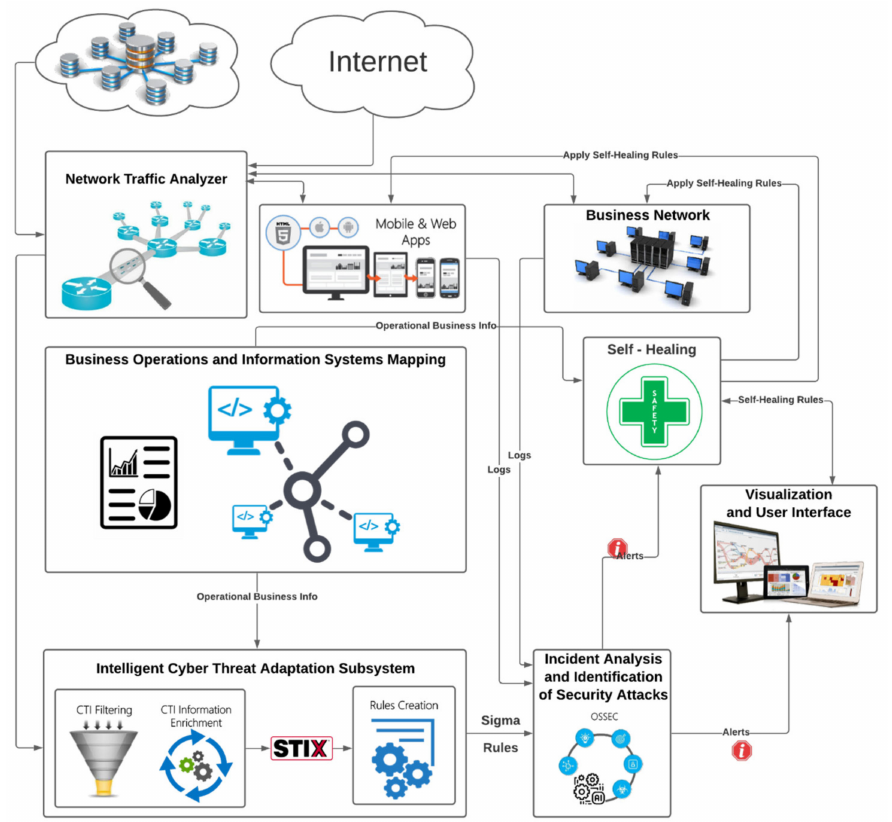
Figure 1. The Cyber Threat Intelligent Information Sharing Architecture